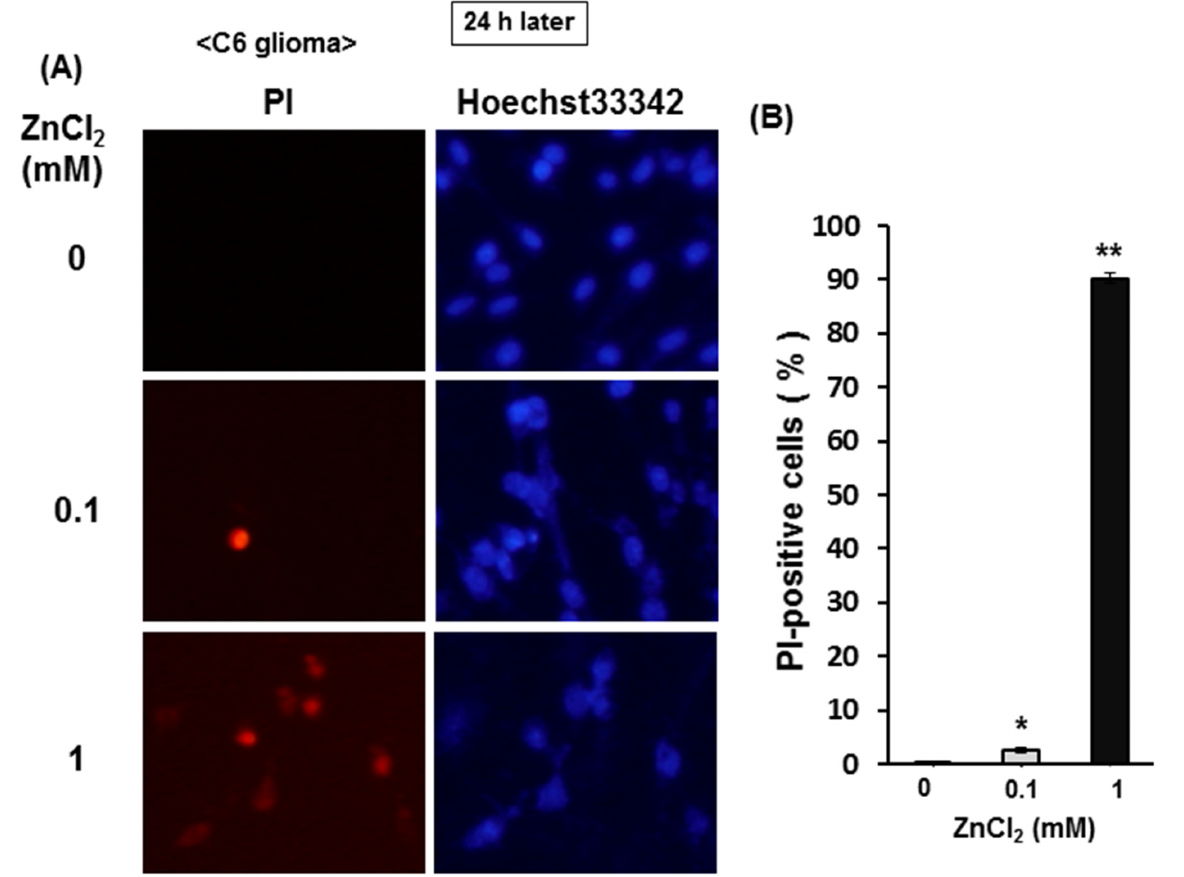
Fig 13. Effects of ZnCl 2 on PI and Hoechst33342 staining in C6 glioma cells. Cells were exposed to ZnCl 2 at concentrations of 0.1 to 1 mM in the presence of CaCl 2 for 1 h, followed by culture for an additional 24 h and subsequent double staining with PI and Hoechst33342 for nuclear DNA. Typical micrographs are shown in the panel (A), while in the panel (B) value are the mean ± S.E. of percentages of PI-positive cells over Hoechst33342-positive cells in 3 independent experiments. * P < 0.05, ** P < 0.01, significantly different from the control value in cells not exposed to ZnCl 2 .